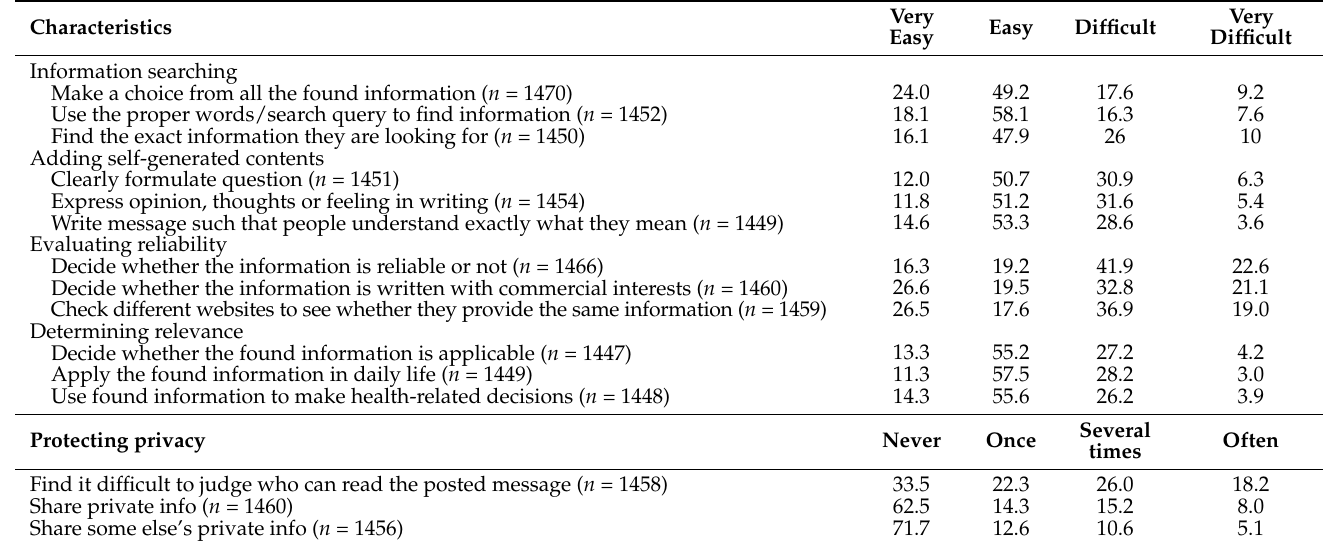
Table 3. Digital health literacy among respondents.